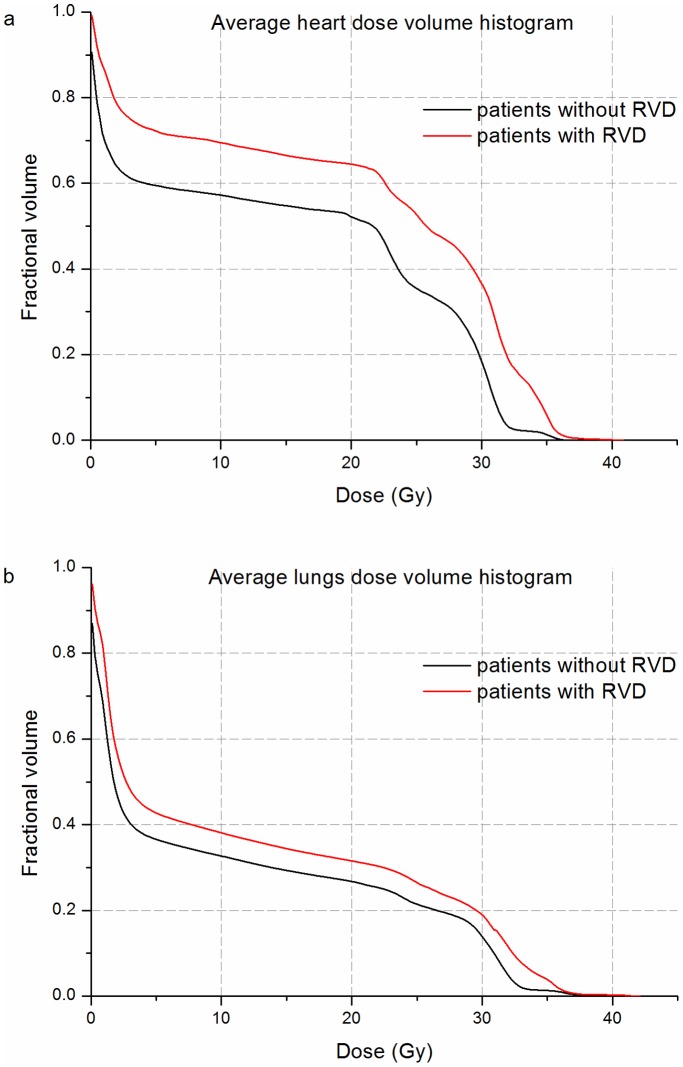
Mean cumulative DVHs for heart (a) and for lung (b).Red line: patients who developed radiation-induced valvular defects; black line: patients who did not develop radiation-induced valvular defects.